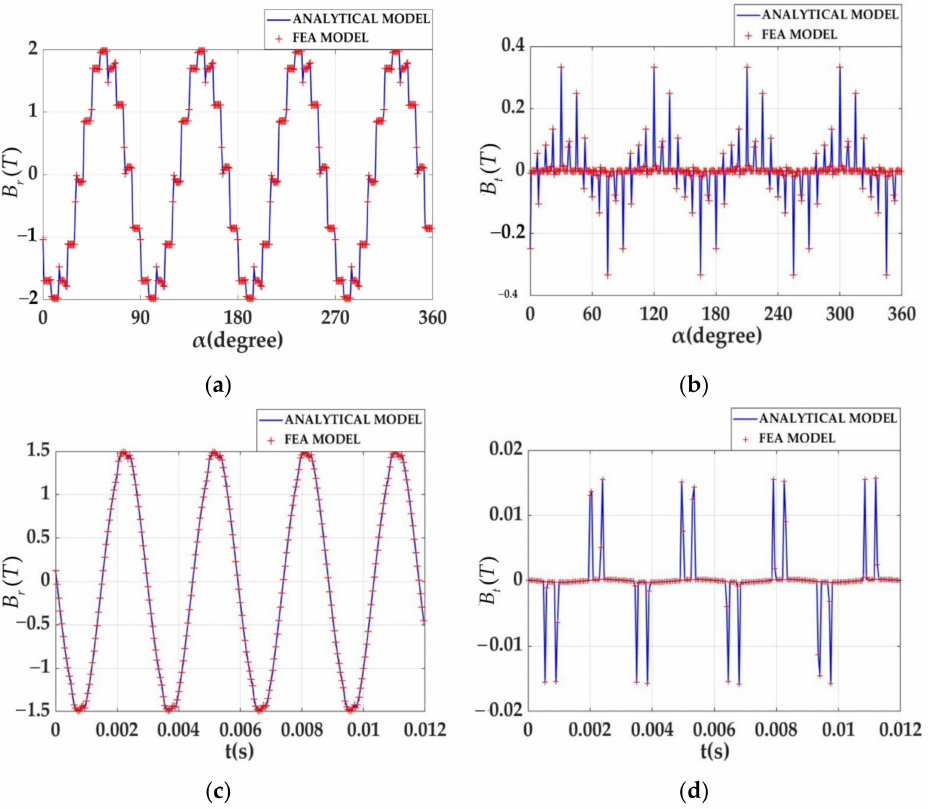
Figure 4. The spatial and temporal distributions of the normal air-gap flux density. ( a ) The spatial distribution of radial flux density; ( b ) The spatial distribution of tangential flux density; ( c ) The temporal distribution of radial flux density; ( d ) The temporal distribution of tangential flux